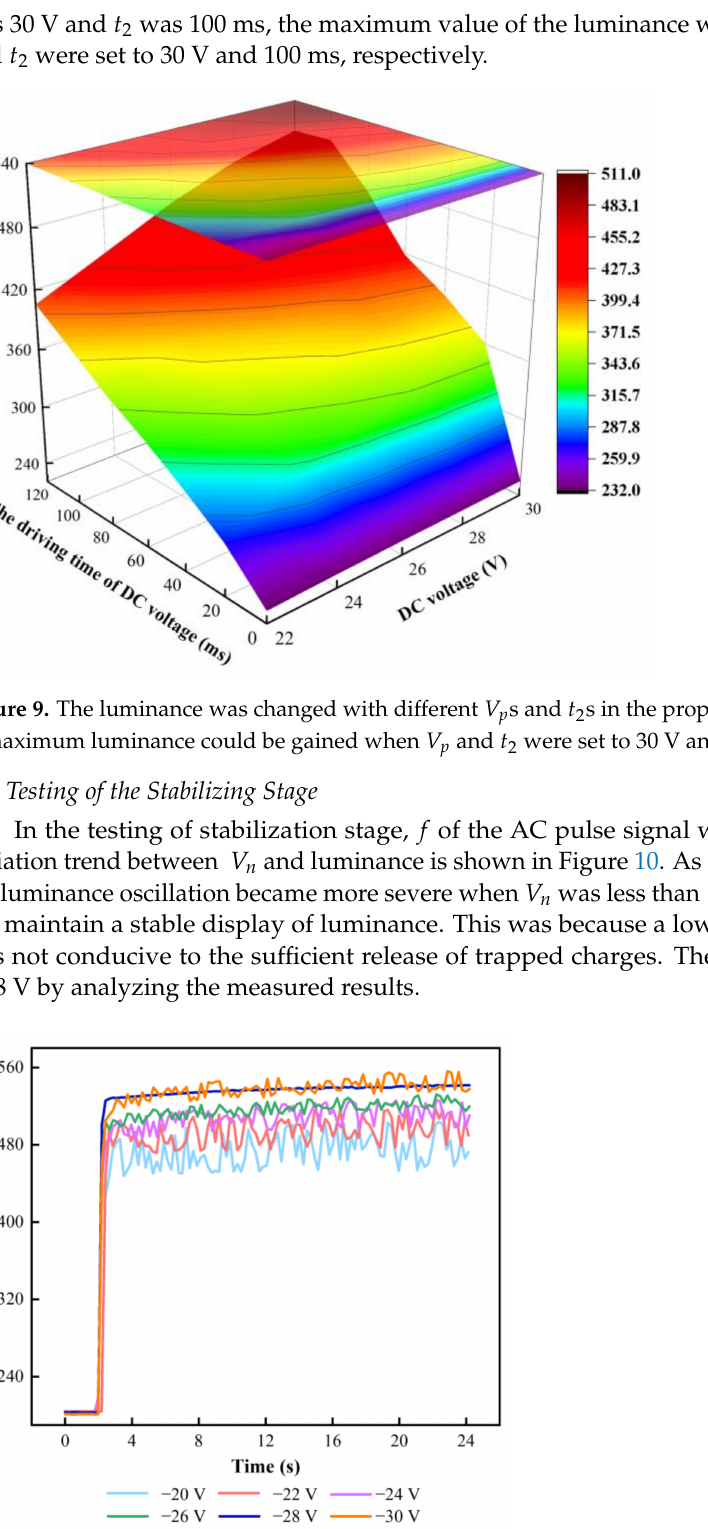
Figure 10. Luminance-time curves of EFDs driven by AC pulse signal with different V n s. With the increase of negative voltage in the stabilizing stage, the degree of luminance oscillation gradually decreased, and the charge trapping phenomenon could be effectively suppressed. The luminance curve was most stable when V n was − 28